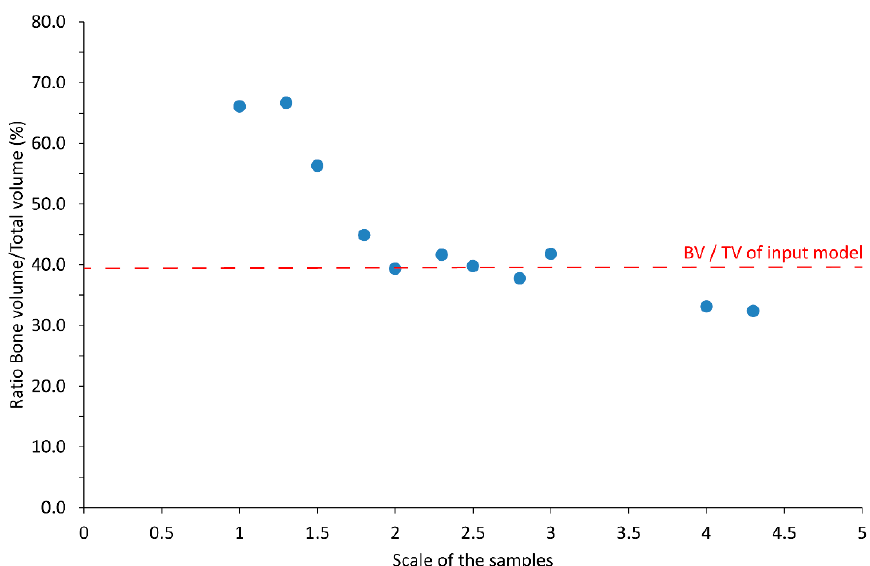
Figure 3. Bone fraction BV/TV (%) as provided after micro-CT and 3D analysis, for samples printed in Black resin at different